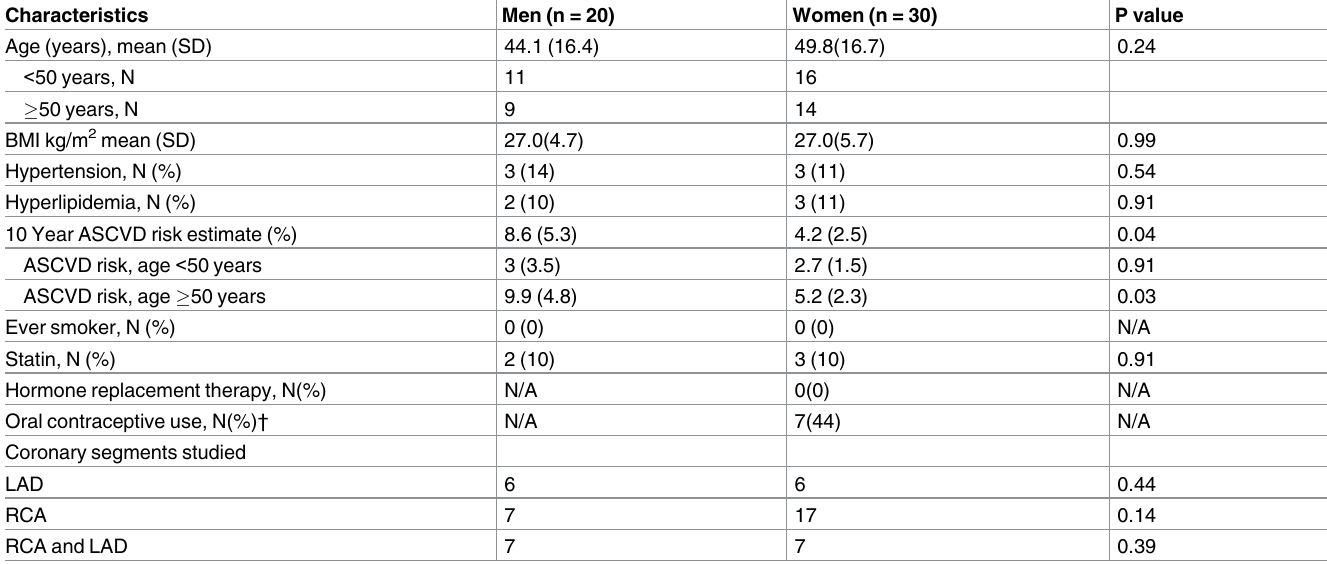
Table 1. Baseline characteristics of the study participants.